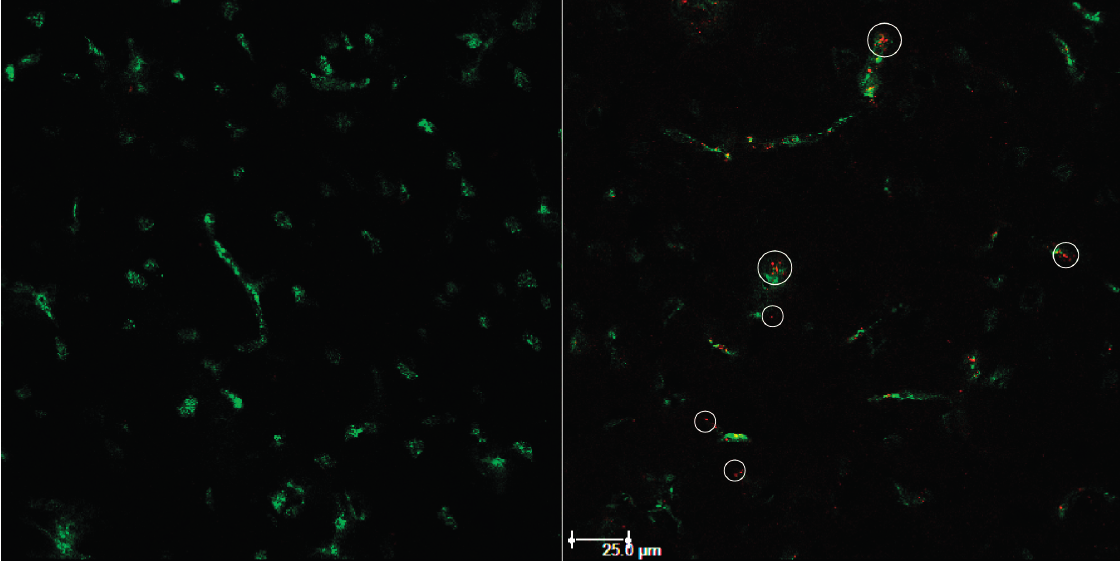
Figure 6. Exemplary image of rat brain cryosection after 3 h of cBSA-liposome incubation ( right ) with control ( left ). Capillaries have been stained with FITC-BSA (green). Liposomal rhodamine B